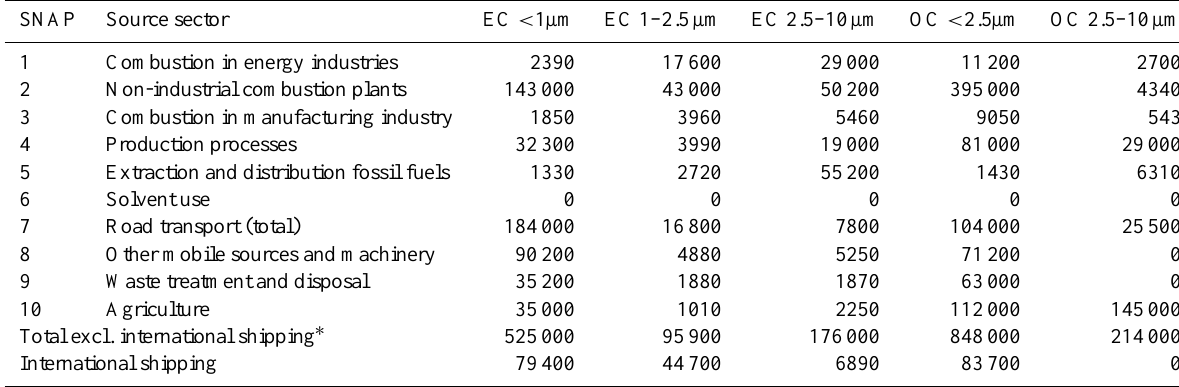
Table 1. Size-differentiated EC and OC emissions (tonnes) for UNECE Europe in 2005.